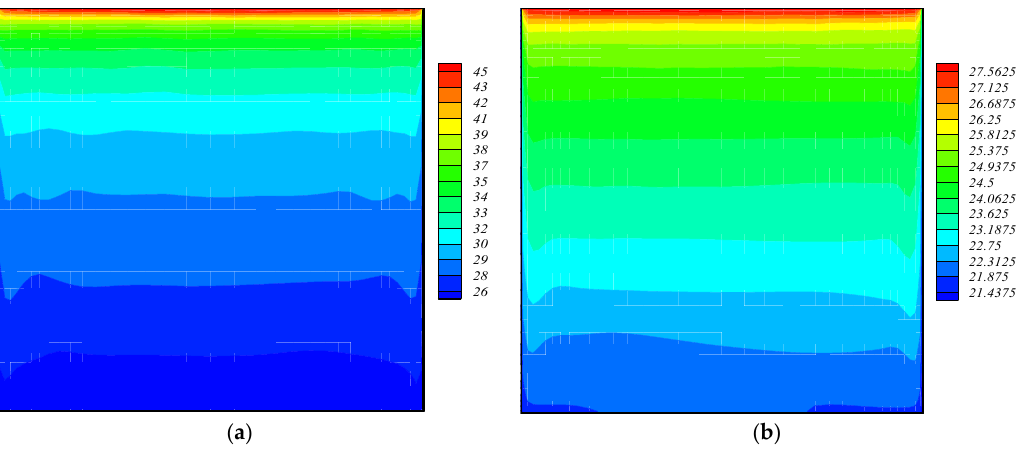
Figure 18. Temperature counters of the roof at 16 h for the room: ( a ) without and ( b ) with PCM.